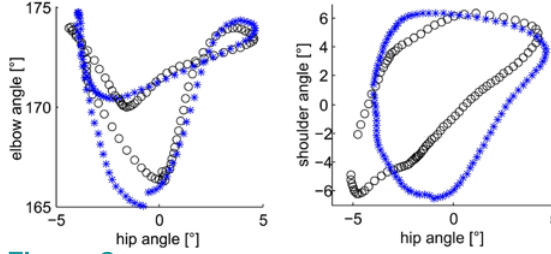
Figure 6. Example of the estimated values (circular symbols) and the observed values (cross symbols) of the hip-elbow and hip-shoulder